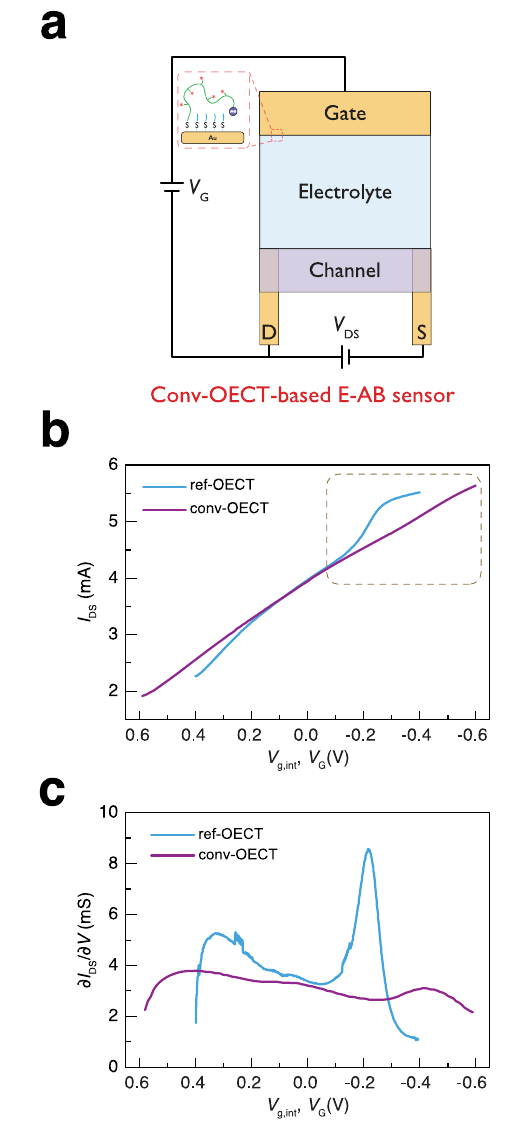
Fig.3|Conv-OECTvs.ref-OECT-basedE-ABsensor.a Testingschemeoftheconv- OECT-based E-AB sensor. b, c Comparison of the channel current and slope of the channel current between ref-OECT and conv-OECT-based E-AB sensor. The scan speedis60mV/sforbothdevicesand V DS is − 0.2V.Maximumslopeofthechannel current is much high in ref-OECT than that in conv-OECT-based E-AB sensor. V g,int describe the voltage drop at gate/electrolyte